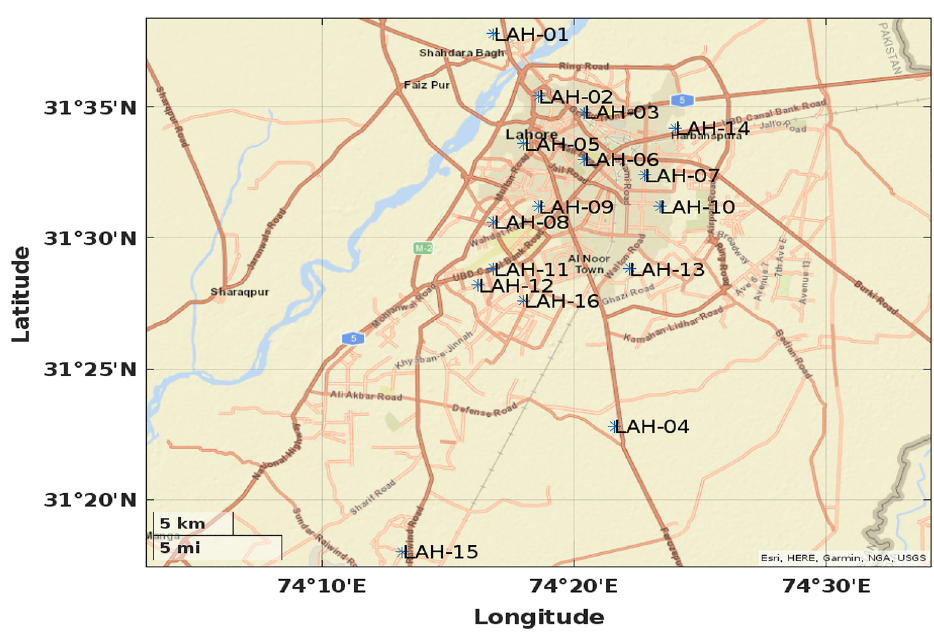
Figure 2. Coordinates placement of electic locations in Lahore (https:// www. mathw orks. com/ help/ matlab/ ref/ geoba semap.